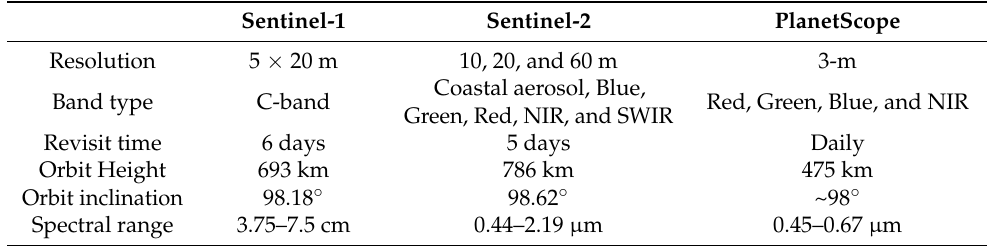
Table 1. Comparison of sensor specifications for Sentinel-1, Sentinel-2, and